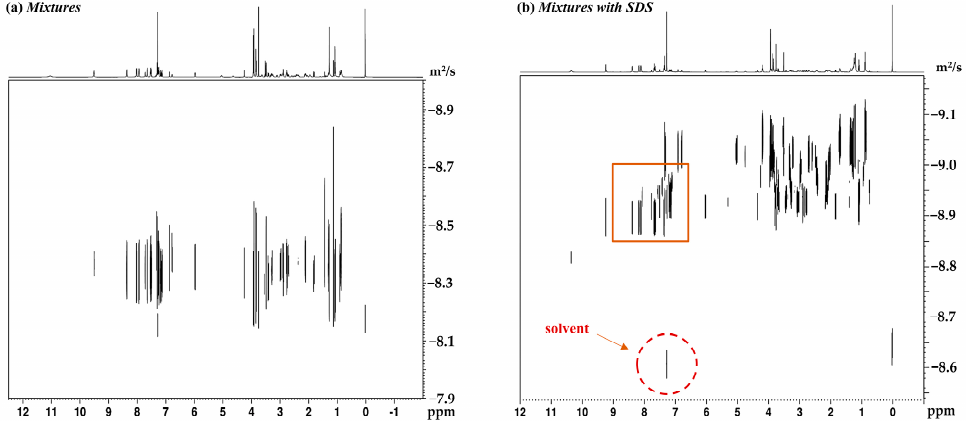
Figure 7. ( a ) DOSY spectrum of mixtures (each component was 2 mg) dissolved in 600 μ L of CDCl 3 . ( b ) DOSY spectrum of the same mixtures as in ( a ), but in the presence of